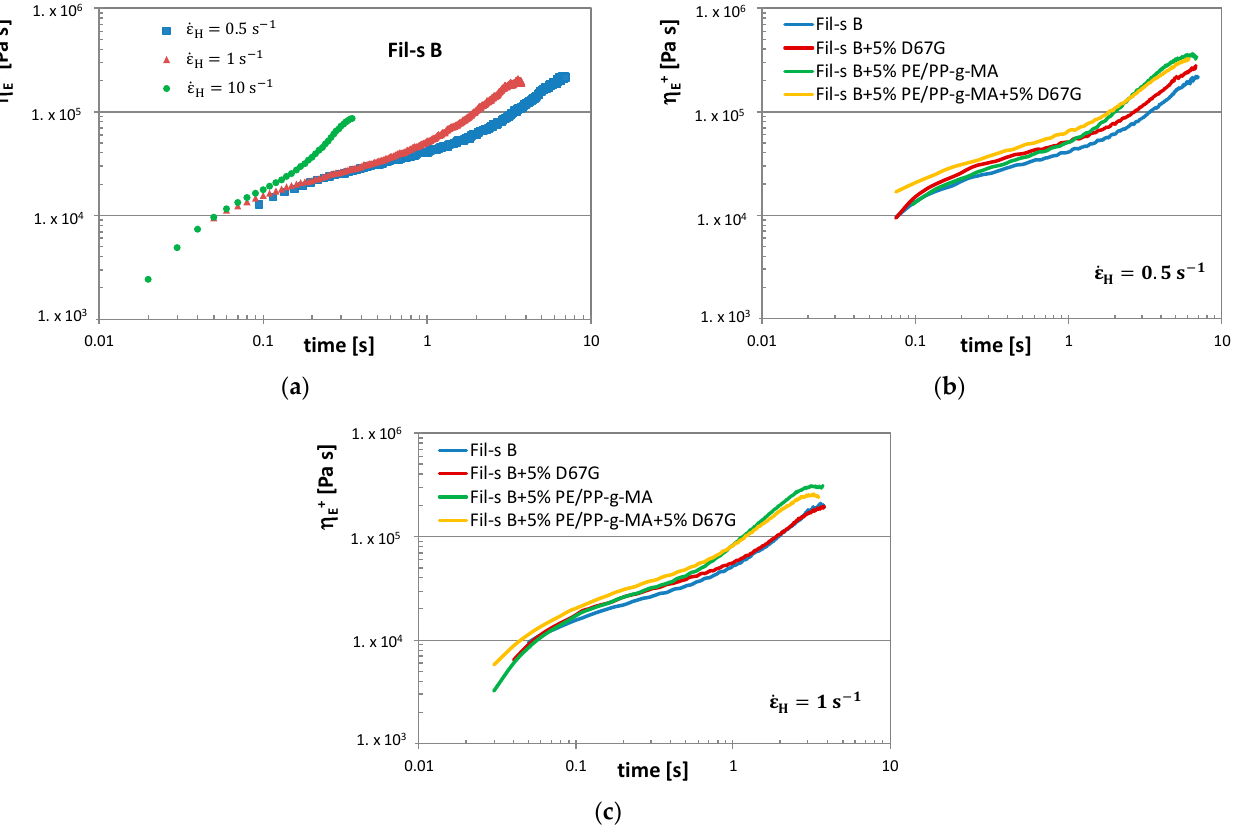
Figure 9. The tensile stress growth coefficients, η E+ , as a function of time and at different Henchy strain rates (0.5, 1 and 10 s − 1 ) are compared for Fil-s B ( a ) and for Fil-s B, Fil-s B + 5% PE/PP-g-MA, Fil-s B + 5% D67G and Fil-s B + 5% PE/PP-g-MA + 5% D67G at Henchy strain of 0.5 s − 1 ( b ) and at Henchy strain of 1 s − 1 ( c ).